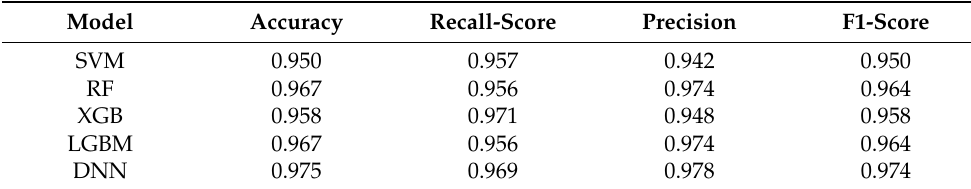
Table 3. Evaluation results for the tested ML